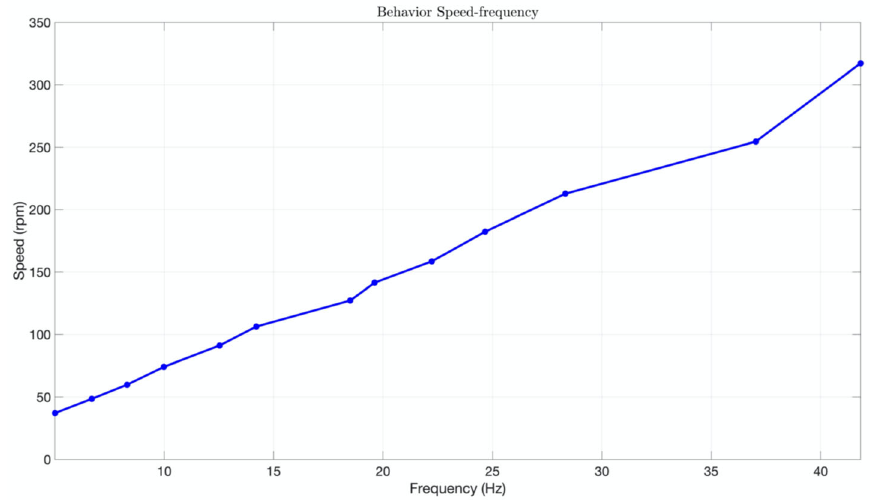
Figure 12. Behavior speed–frequency.